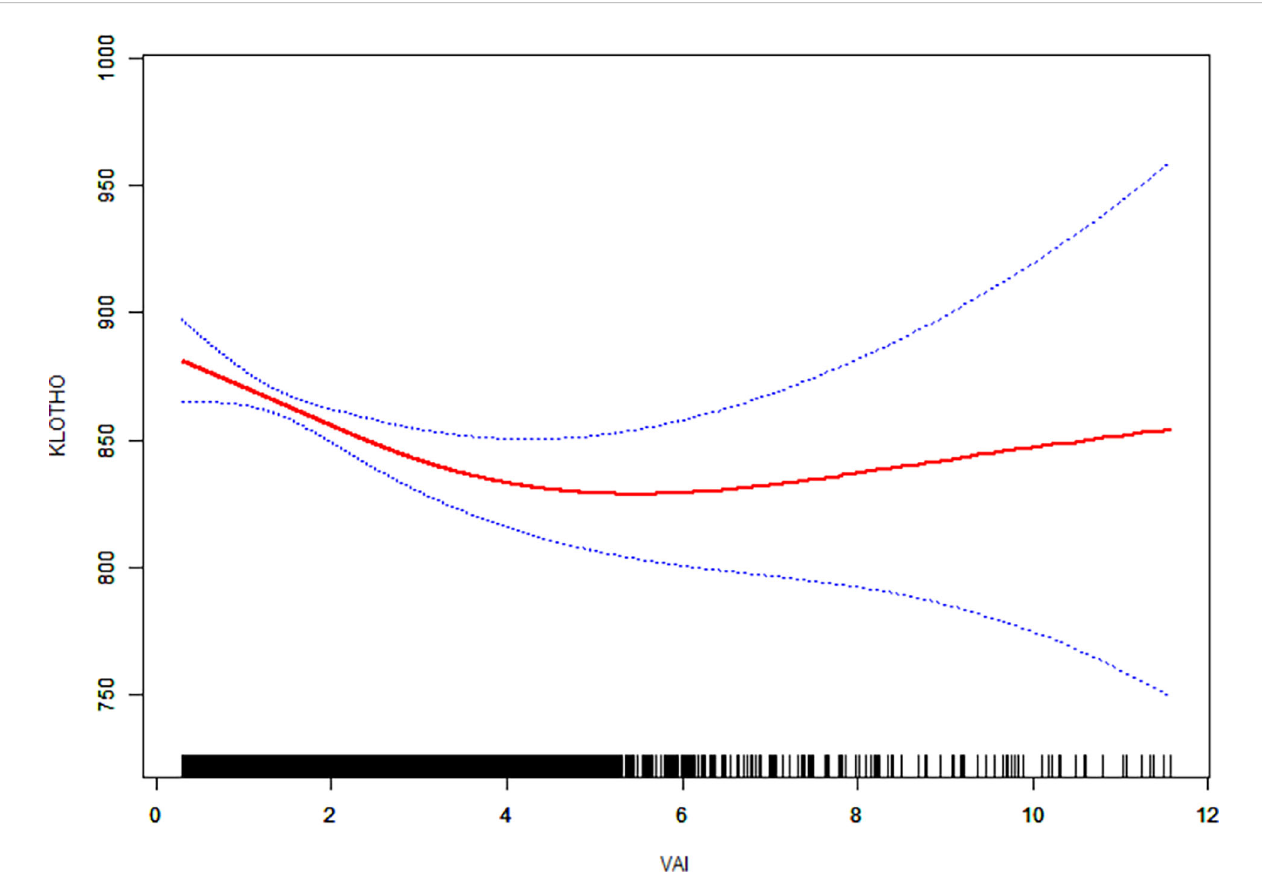
FIGURE 1 The relationship between visceral adiposity index (VAI) and serum anti-aging protein klotho. Solid line in the middle represents smooth curve fi tting between variables. The dotted line on both sides represents a 95% con fi dence interval (CI) for the fi t. The bottom black and white strip shows the population density according to VAI. All models were adjusted for gender, age, race, poverty income ratio, body mass index, education, marital status, physical activity, smoking, alcohol use, chronic kidney disease, cancer, diabetes, hypertension, stroke, chronic obstructive pulmonary disease, and cardiovascular